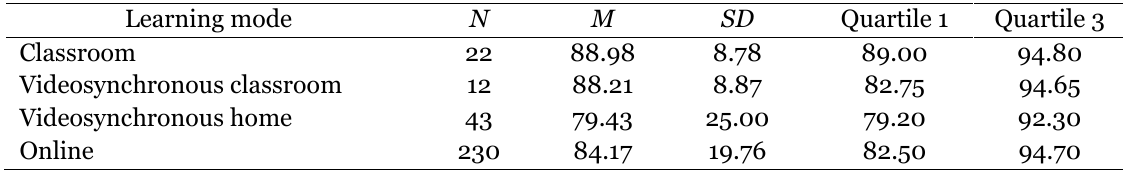
Means and Standard Deviations of End-of-Course Scores Based on Learning Mode Learning mode N M